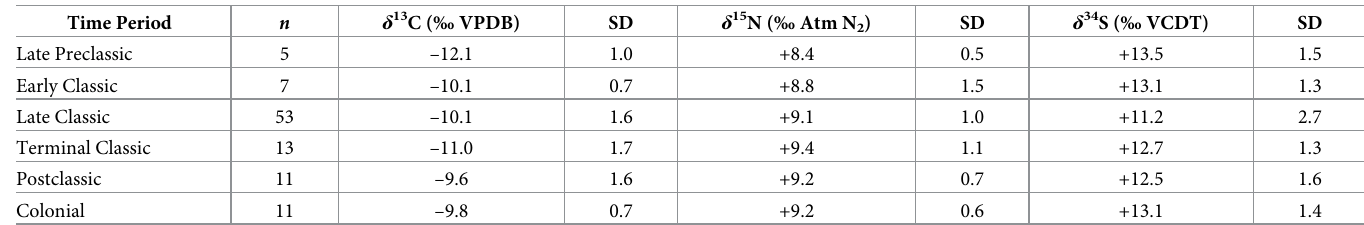
Table 4. Mean isotopic values for human bone collagen by time